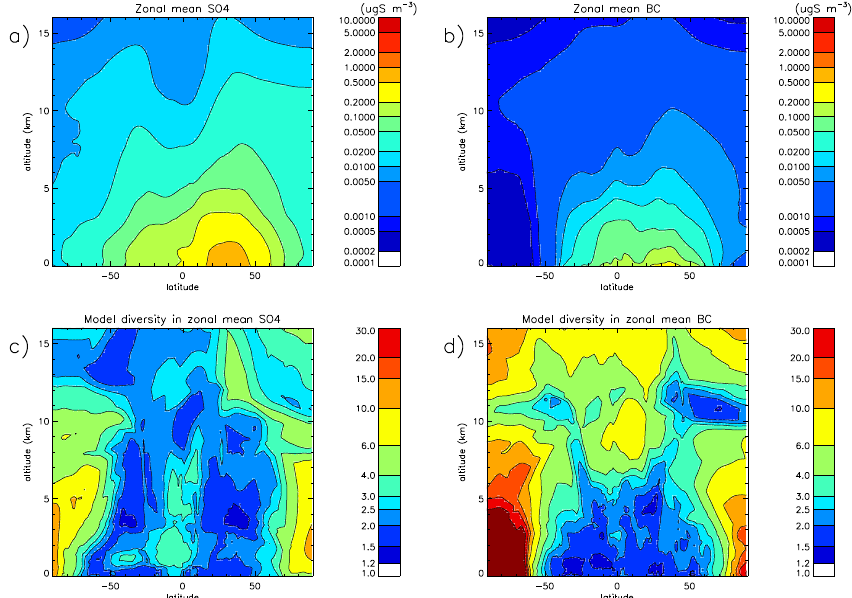
Figure 3. Zonal-mean vs. latitude and altitude plots of central-8 model mean and diversity for simulated annual mean mass concentrations of sulfate (a, c) and black carbon (b, d) . Diversity here is the ratio of the maximum and minimum values over the central 8 of the 12 models (defined locally, as described in Sect. 2.4). All concentrations are with respect to local temperatures and pressures in the models. Note that the geometric mean is used when averaging over the central-8